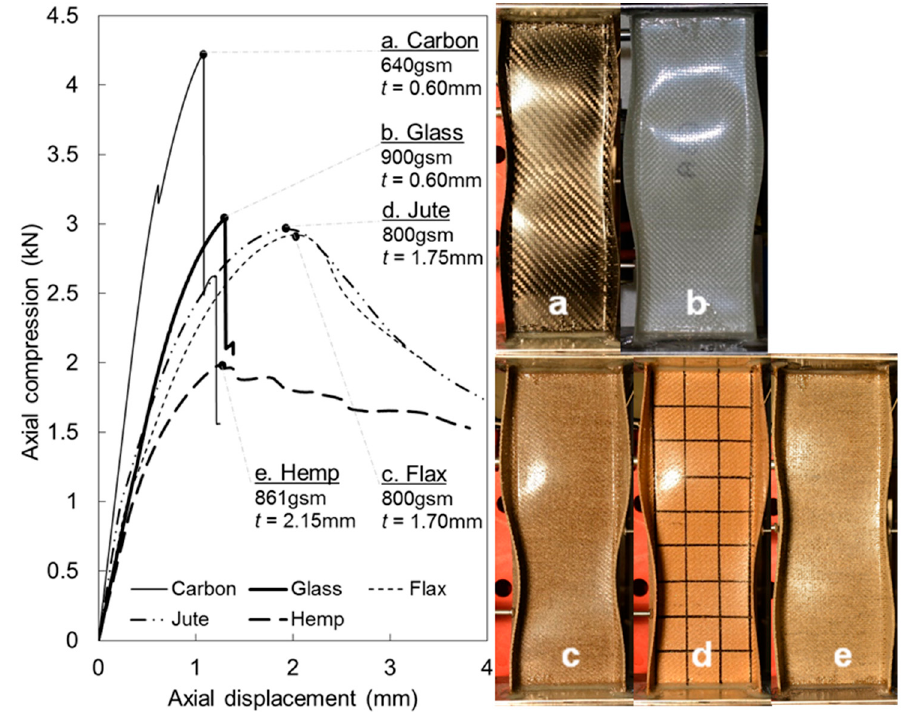
Figure 5. Exemplar composite channel compression tests for the approximately 800 gsm total fiber areal mass comparator group (640–900 gsm) (all column heights are 300 mm).